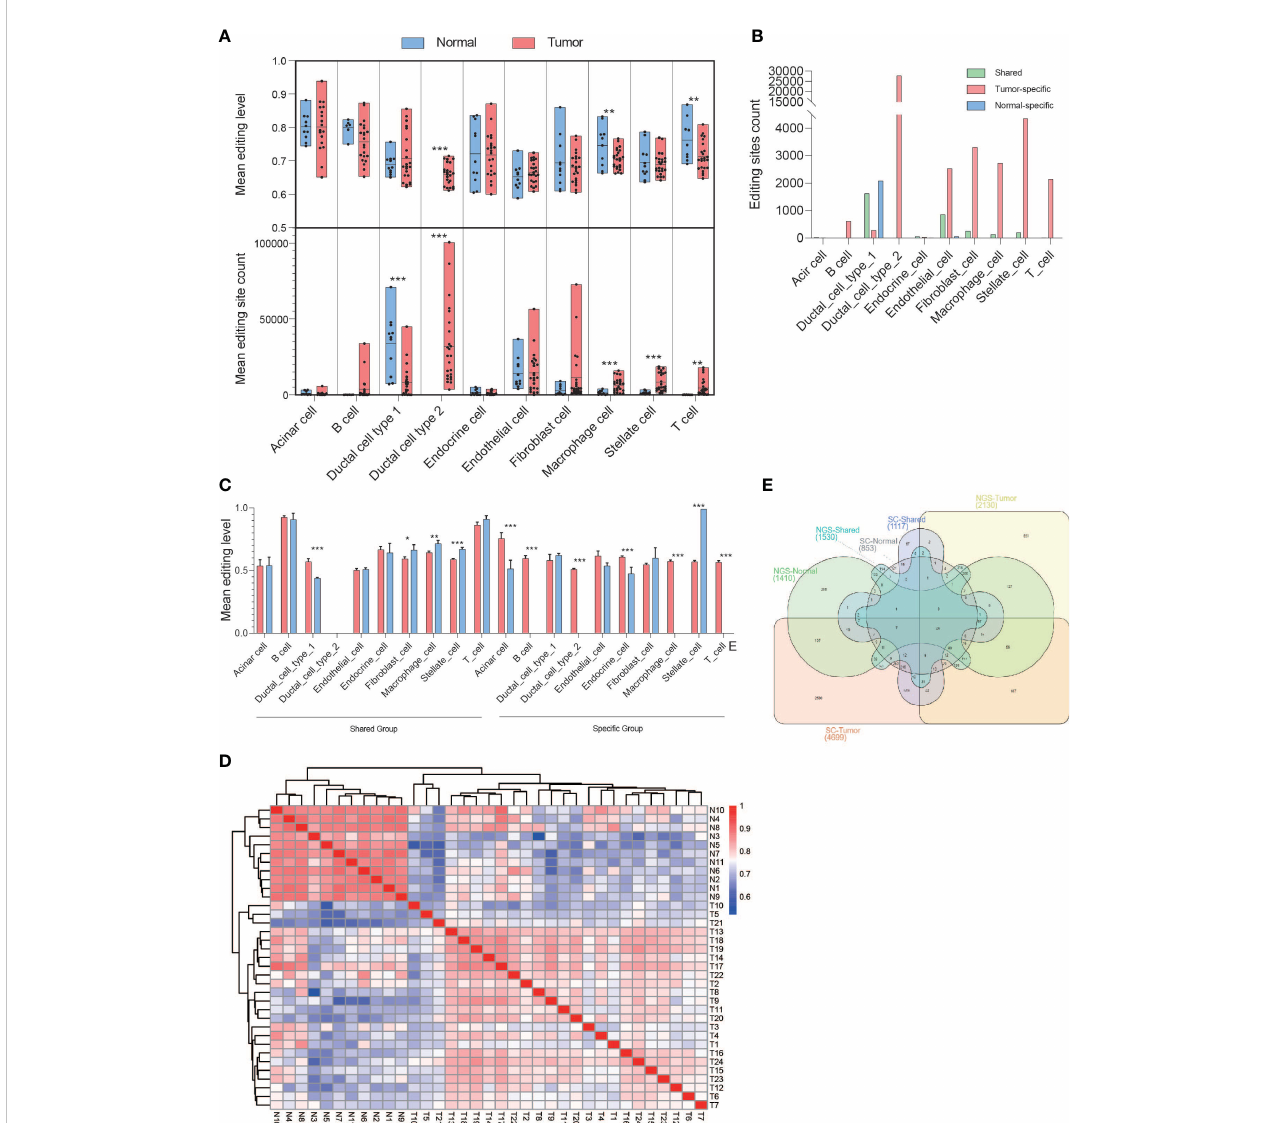
FIGURE 7 Biased A-to-I DREs in various PDAC cell types based on single-cell sequencing. (A) The box diagrams displayed mean editing level (upper) and mean editing site count (bottom) among 10 kinds of PDAC cell types in general. (B) Bar diagram displaying the distribution of DREs in each PDAC cell type among the shared, tumor-speci fi c, and normal-speci fi c groups. (C) Bar diagram displaying the mean editing level of DREs in each PDAC cell type among the shared, tumor-speci fi c, and normal-speci fi c groups. (D) Heatmap showing the correlation among tumor and normal samples. (E) Venn diagram showing the distribution of genes with DREs among the shared, tumor-speci fi c, and normal-speci fi c groups based on NGS and single-cell sequencing data. *p < 0.05, **p < 0.001, ***p <